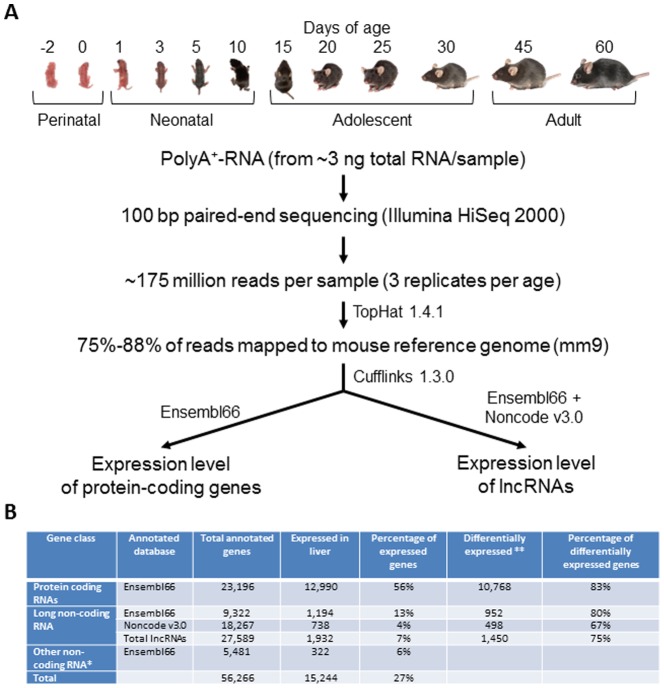
Identification of lncRNA in mouse liver.(A) Pipeline for gene annotation and identification of lncRNAs. (B) Number of Protein-coding genes and lncRNAs expressed during liver postnatal maturation. *Other non-coding RNAs include Ensembl66 annotated t-RNAs, r-RNAs, miRNAs, snRNAs, snoRNAs, and miscRNAs. **ANOVA was used to test for significant difference in expression during development. P-values were adjusted using Benjamini-Hochberg algorithm with a threshold of 0.05.